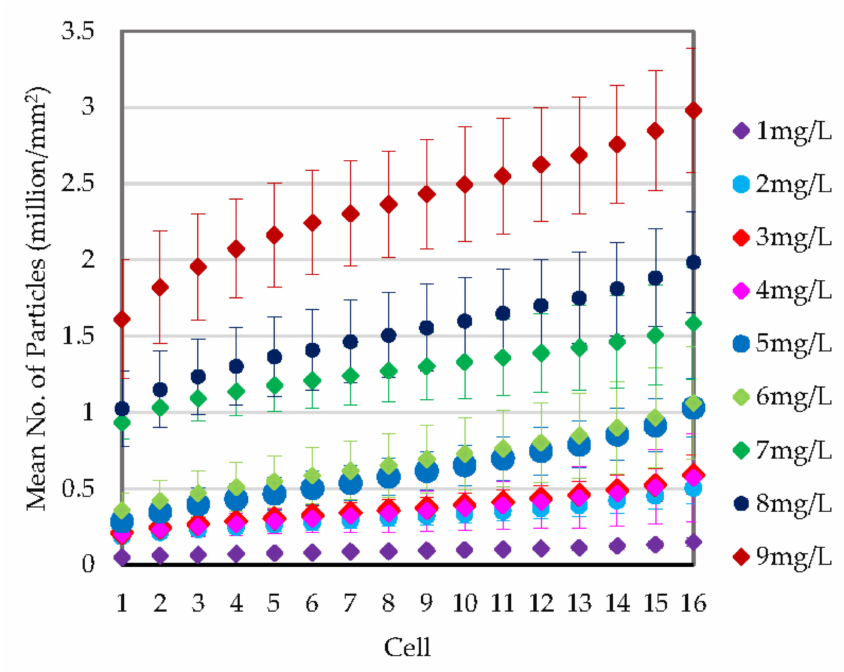
Figure 11. Particle distribution on 16 cells of SEM images, ordered from the minimum to the maximum particle counts. Error bars indicate standard